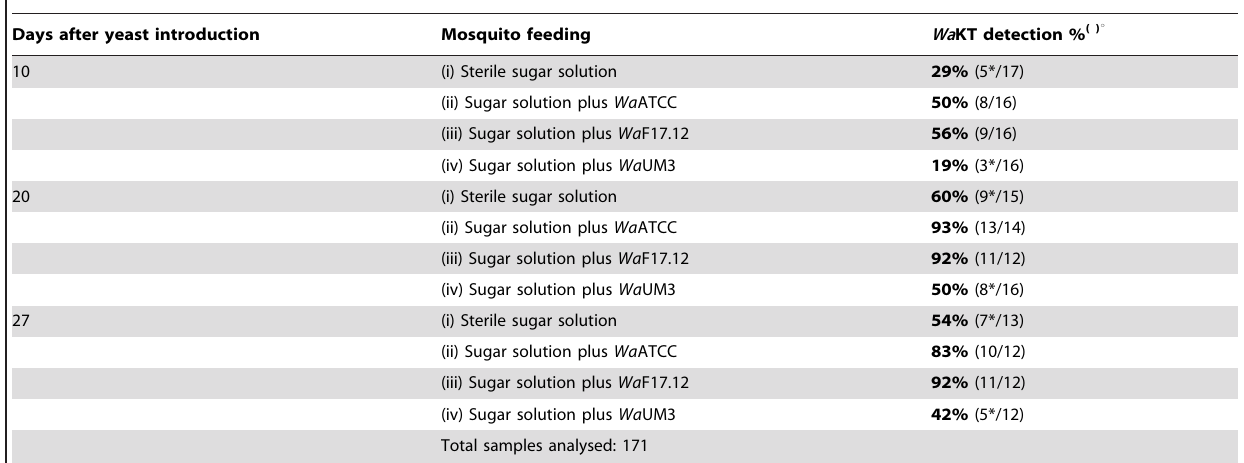
Table 1. In vivo detection of Wa KTs in An. stephensi by IFA with mAbKT4.